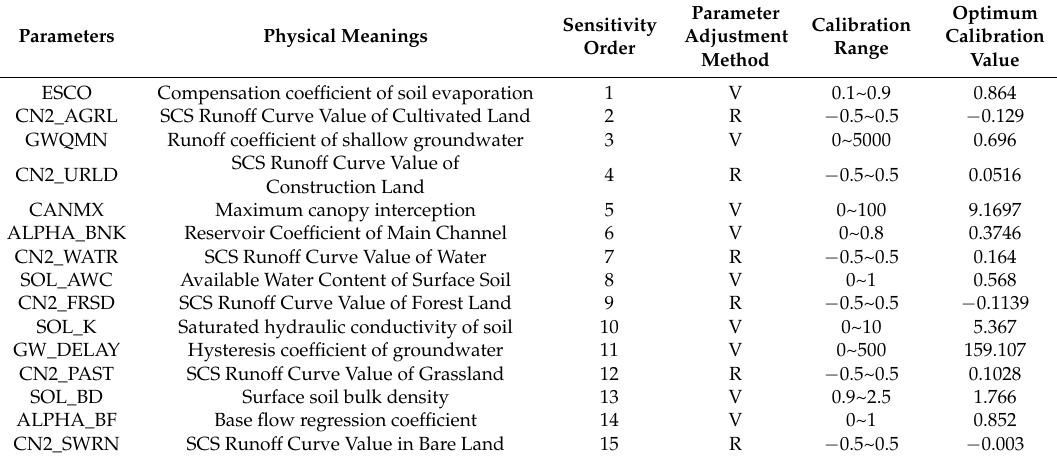
Table 1. Sensitive parameters for runoff and results of parameters calibration in the Xihe River Basin.